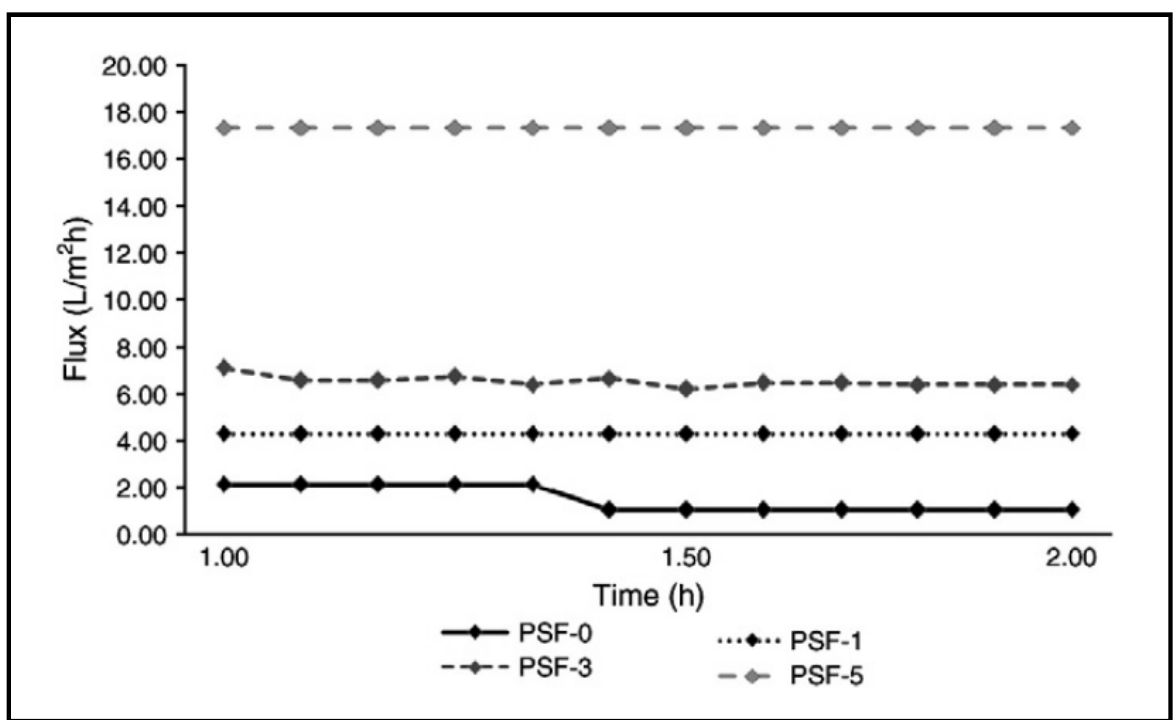
Figure 5. Permeate flux of polysulfone/silicon dioxide (PSf/SiO 2 ) membranes. Reprinted with permission from ref. [23]. © 2010 Elsevier B.V.